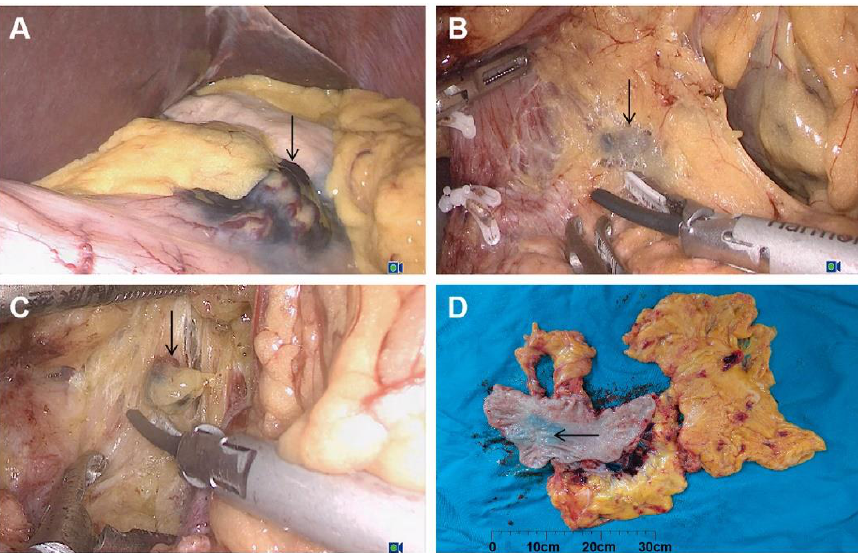
Figure 3. Carbon nanoparticle-labeling helped to find the lesion site (gastric angle) ( A ) and in draining lymph nodes ( B , C ) in laparoscopic radical gastrectomy. ( A ) Gastric angular lesions labeled with carbon nanoparticles; ( B ) black staining of lymph node no. 8a; ( C ) black staining of lymph node no. 11p; ( D ) gross specimen. Reproduced with permission [94]. Copyright 2021, Elsevier.